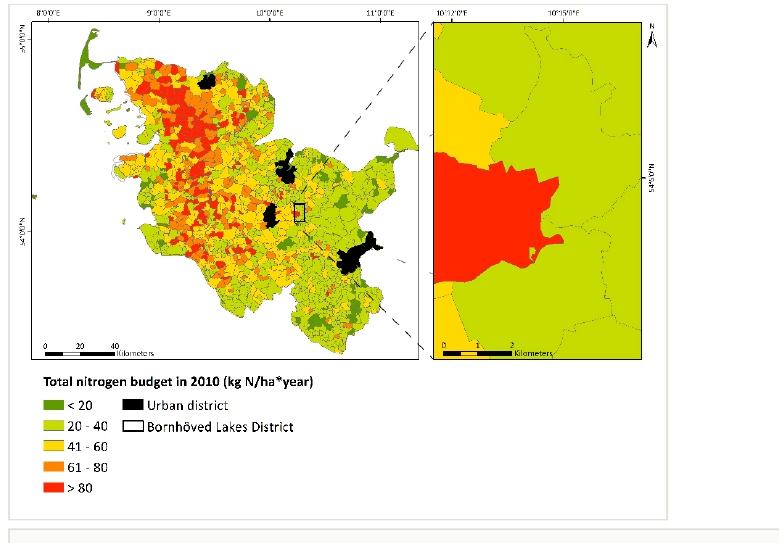
District (right) on the municipality scale (data on agricultural census 2010 from Statistikamt boundaries from GeoBasis-DE / BKG